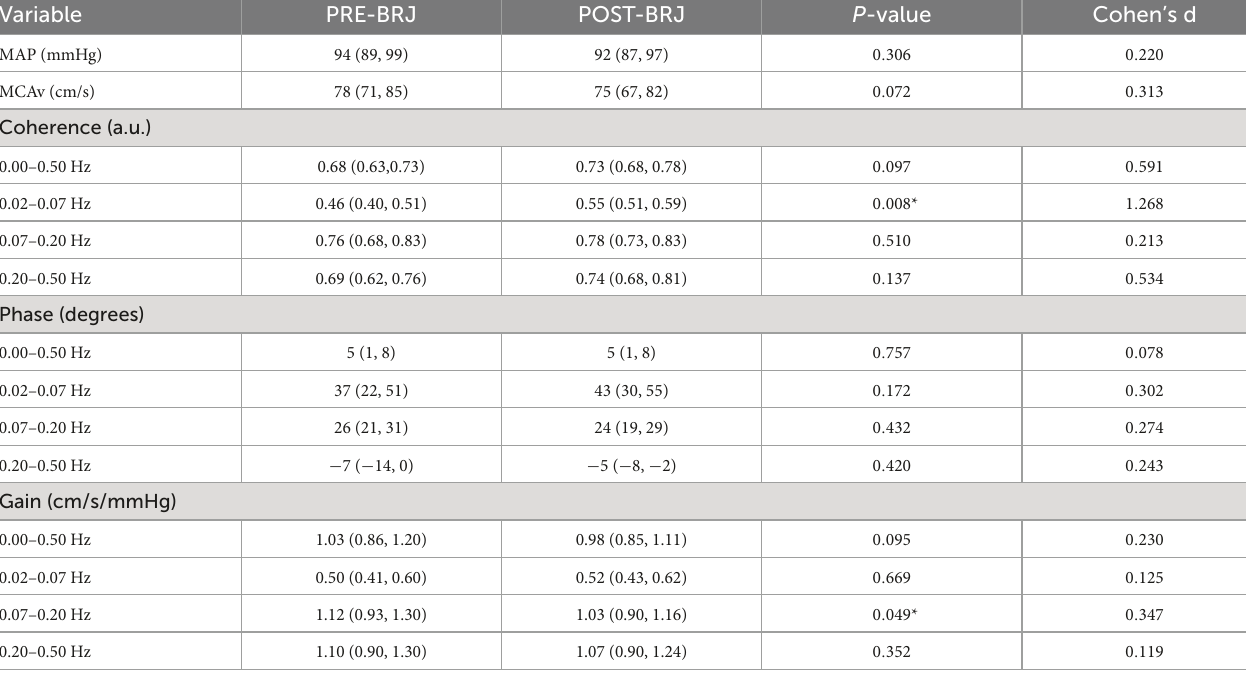
TABLE 1 Blood pressure, cerebral artery blood velocity, and indices of cerebral autoregulation indices of dynamic cerebral autoregulation during oscillatory lower-body negative pressure before and 3 h after beetroot juice (BRJ) consumption. Variable PRE-BRJ POST-BRJ